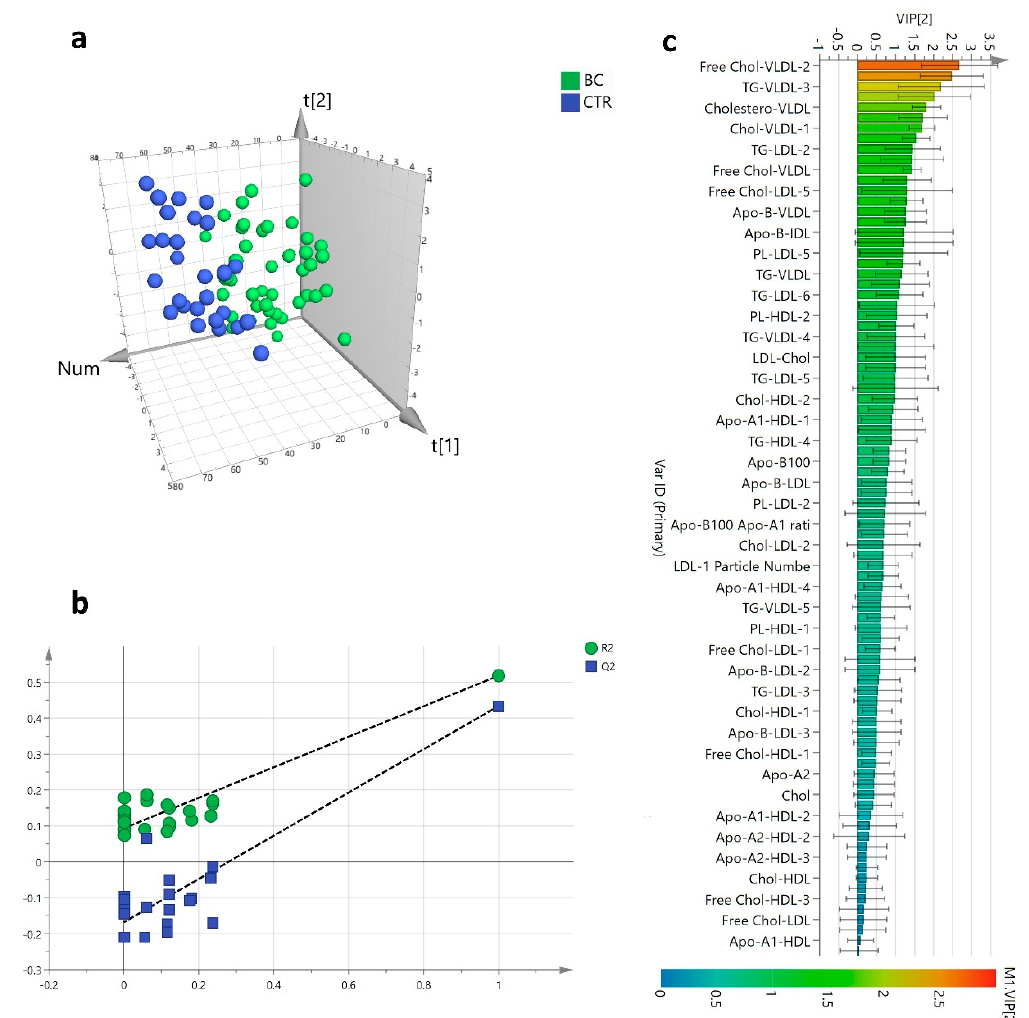
Figure 2. Plasma lipoproteins profiles PLS-DA score plot of HER2-positive BC patients ( n = 43) and the CTR group ( n = 28) ( a ); Permutation test plot showing R 2 (green) and Q 2 (blue) values from the permuted models ( b ); Variable importance plot for the projection (VIP) score of the PLS-DA model ranked by increasing values ( c ).